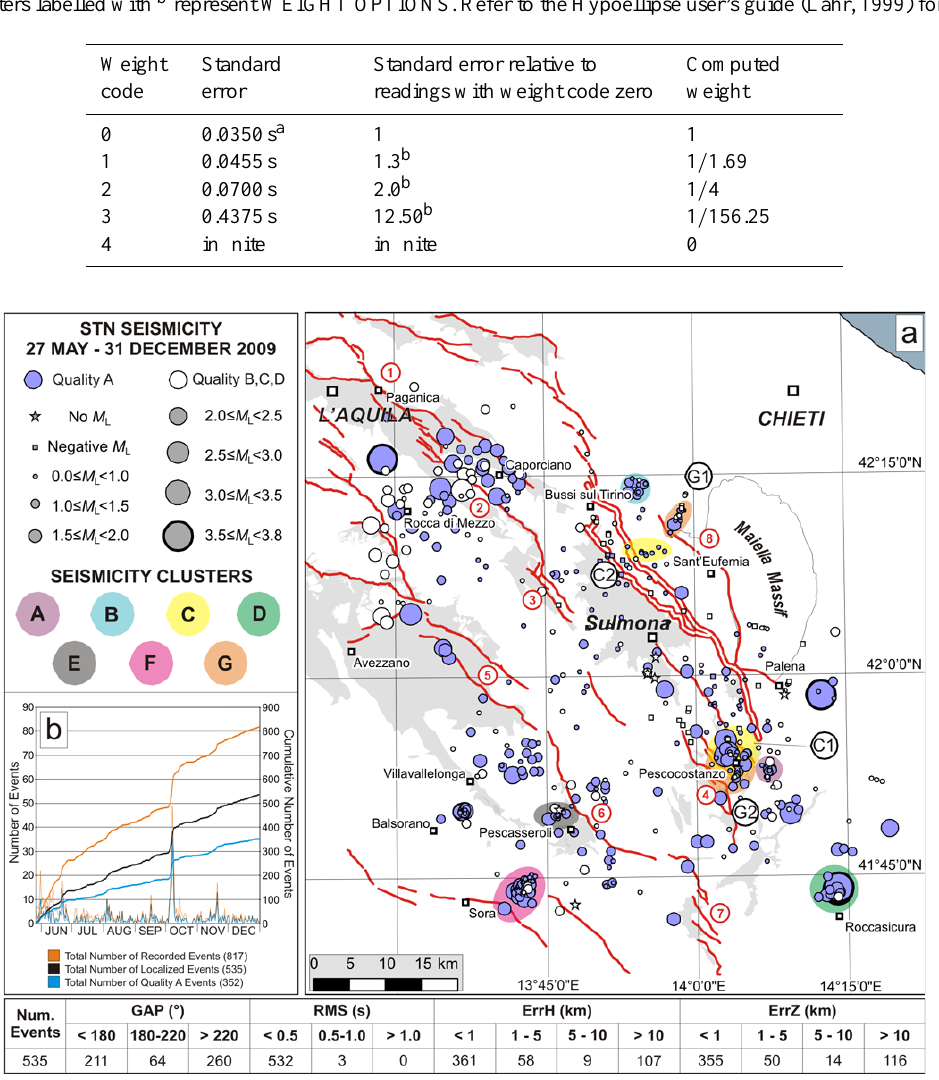
Table 3. Weighting scheme adopted for the locations performed by using Hypoellipse. The parameter labelled with a represents RESET